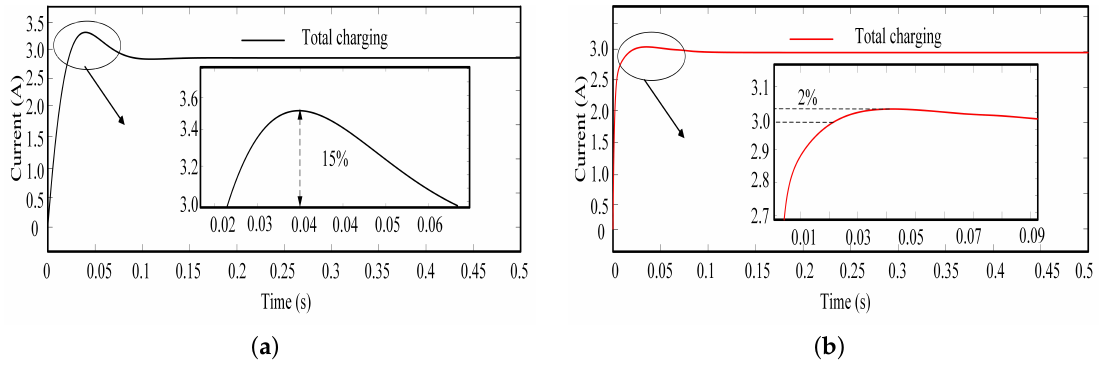
Figure 3. Simulation results of ( a ) the classical charging method and ( b ) the proposed charging method.